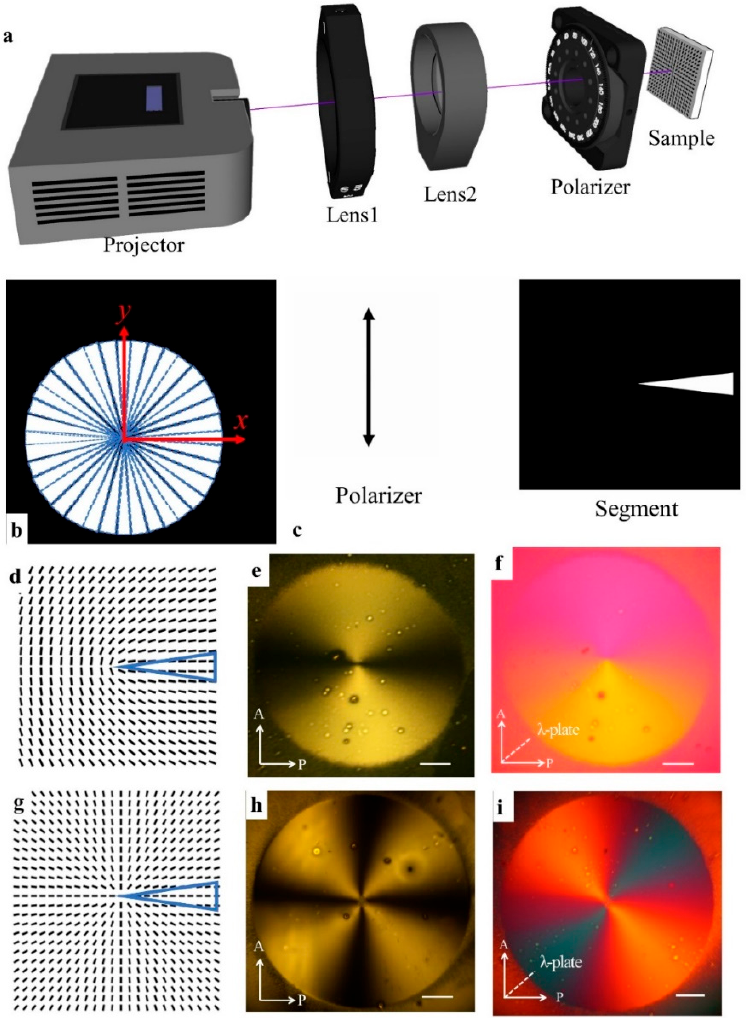
Figure 2. Illustration of photopatterning process. ( a ) A maskless photopatterning setup by projection display. ( b ) The pattern is divided into 36 segments evenly. ( c ) The starting positions of the polarizer and segments for producing director filed in ( d , g ). ( d ) The director field of +1/2 defect. ( e , f ) The POM images of +1/2 defect without ( e ) and with ( f ) the red plate. If the slow axis of the “red plate” is in the same direction as the LC alignment, the interference color will be “violet” or “blue”, indicating an increase in retardance. ( g ) The director field for a radial +1 defect. ( h , i ) The POM images of the radial +1 defect without ( h ) and with ( i ) the red plate. Scale bars in all images are 2.5 mm. The blue triangles in ( d , g ) are the starting positions of the segments. P and A represent polarizer and analyzer. For example, when the polarizer axis is aligned along the y -axis at the beginning of the process, Figure 2c, and it jogs 5 ◦ per 10 s in the CW sense, the angular speed of the polarizer is R 1 = 5 ◦ /10 s. The obtained topological charge will be m = R 1 / R 2 = + 1/2, Figure 2d. The desired pattern with +1/2 defect will be created after a full 2 π rotation of segments, Figure 2e,f. For the director field of m = + 1 with pure splay θ 0 = 0, Figure 2g, the polarizer is programmed by LabView to start along the y -axis and maintain a speed of R 1 = 10 ◦ /10 s in the CW sense. Hence, the obtained topological charge is m = R 1 / R 2 = + 1. After a